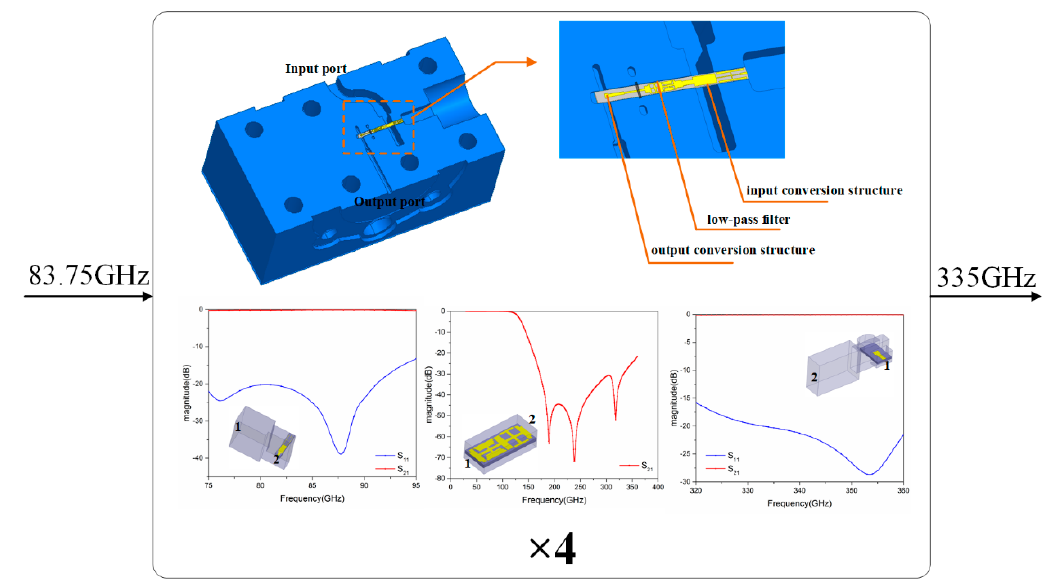
Figure 7. Three-dimensional model of the 335 GHz source based on a single-stage quadrupler.